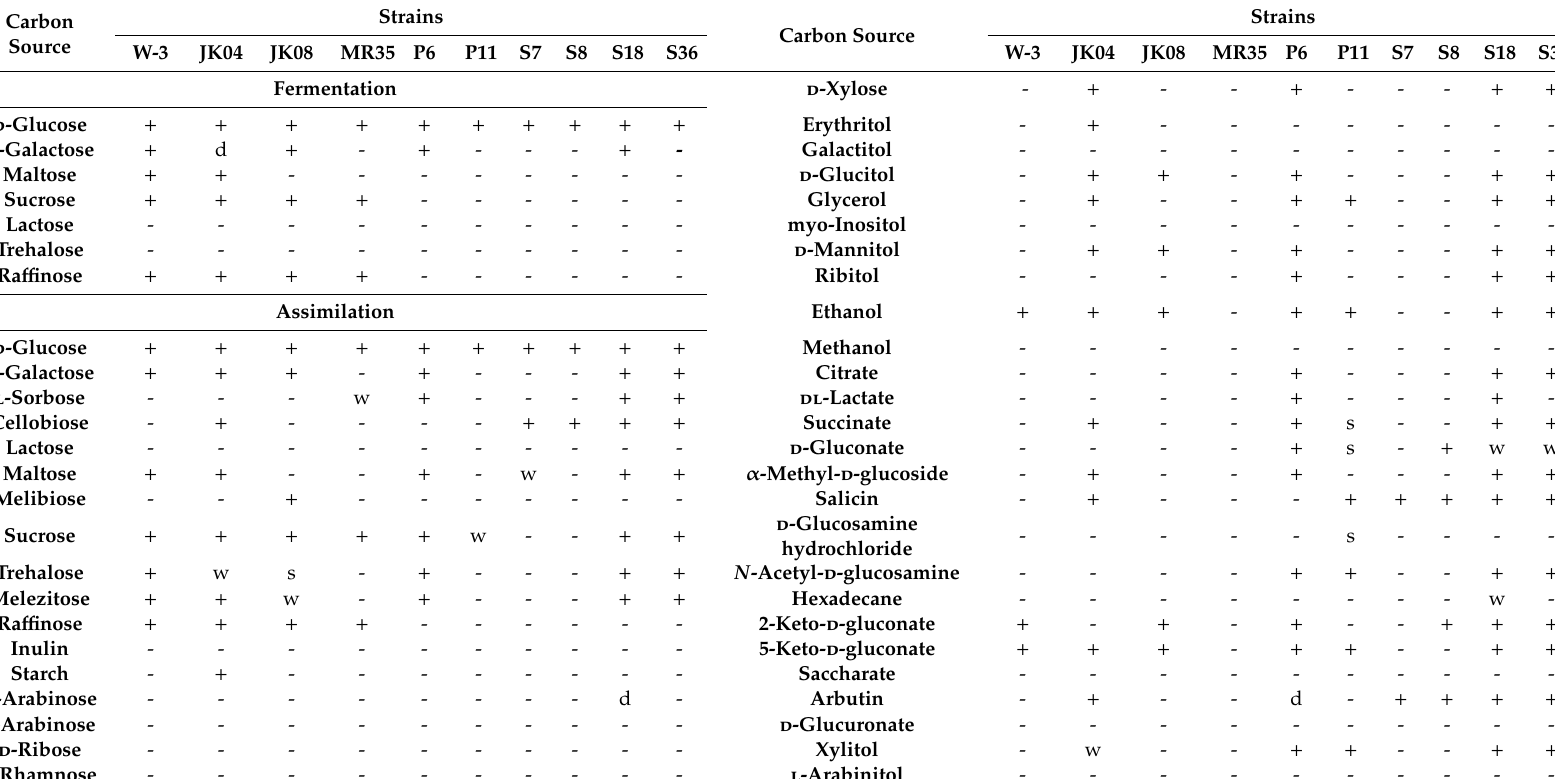
Table 2. Carbon fermentation and assimilation characteristics of Saccharomyces cerevisiae W-3 and nine non- Saccharomyces yeasts. Carbon Source